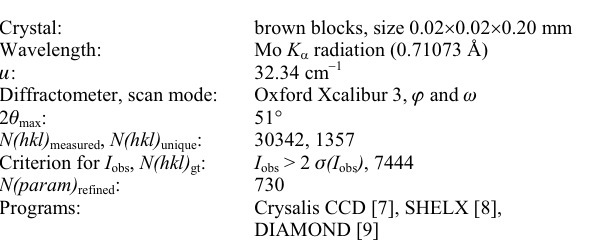
Table 1. Data collection and